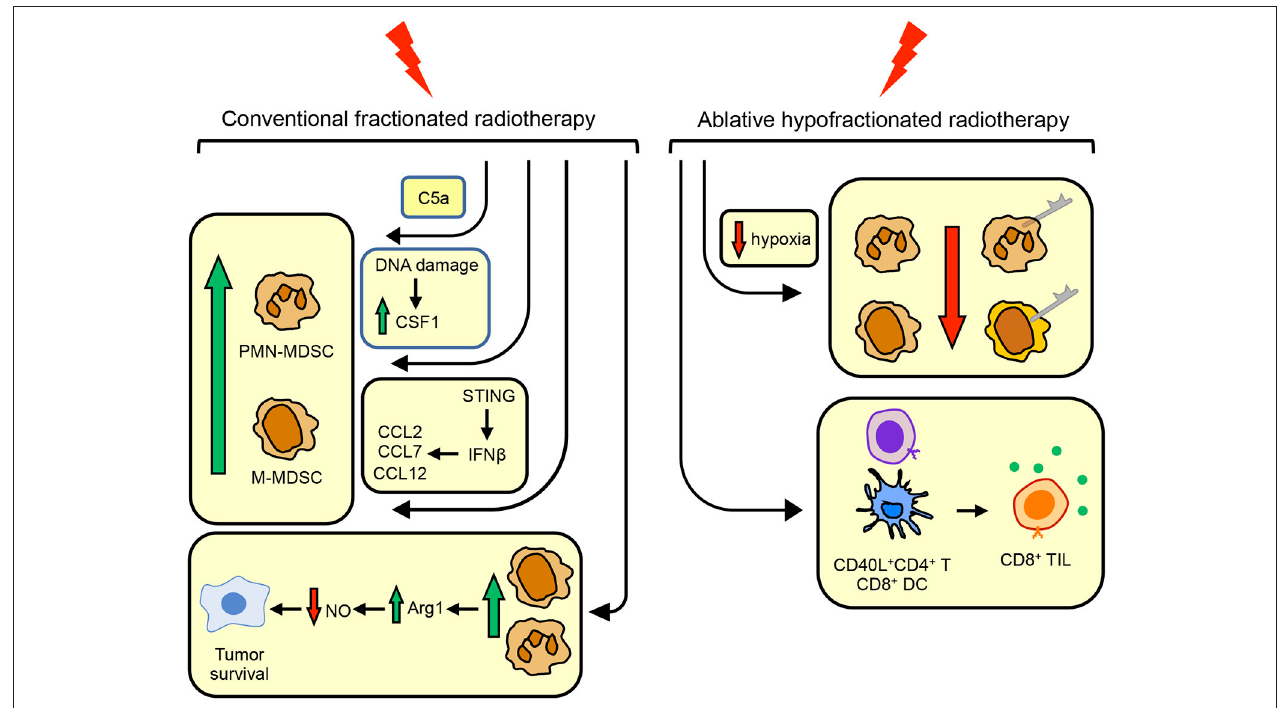
FIGURE 1 | Conventional fractionated radiotherapy (CFRT) increases MDSC while ablative hypofractionated radiotherapy (ABHRT) decreases MDSC. CFRT increases the quantity of MDSC by (i) inducing the complement component C5a; (ii) causing DNA damage resulting in the up-regulation of CSF1; or (iii) signaling through STING to increase IFN β which up-regulates CCL2, CCL7, and CCL12, chemoattractants for MDSC. MDSC up-regulated by CFRT facilitate tumor cell survival by their production of arginase 1 which decreases nitric oxide, a radiosensitizing molecule. ABHRT enhances antitumor immunity by reducing intratumoral hypoxia which decreases the quantity of MDSC and MDSC expression of PD-L1, resulting in increased levels of CD40L + CD4 + T cells and CD8 + DC which activate CD8 + TIL.